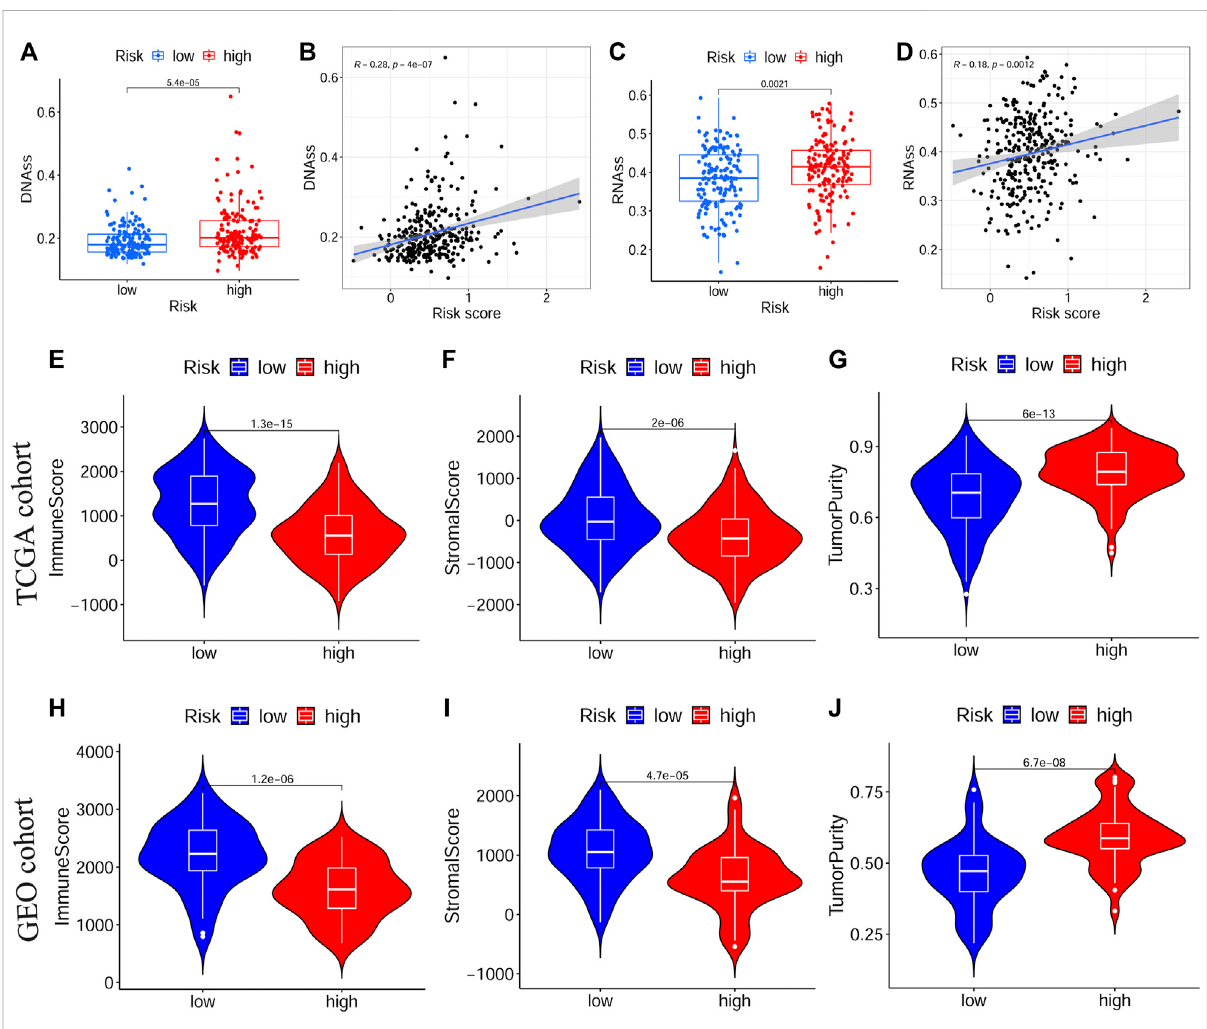
FIGURE 5 The tumor stemness and immune microenvironment between different risk subgroups. (A,B) Comparison of DNAss and RNAss in different risk subgroups. (C,D) The relationship between risk score and DNAss or RNAss based on TCGA cohort. (E – G) The immune score, stromal score and tumor purity between different risk groups in TCGA cohort. (H – J) The immune score, stromal score and tumor purity between different risk groups in GEO cohort. TCGA, The Cancer Genome Atlas, GEO, The Gene Expression